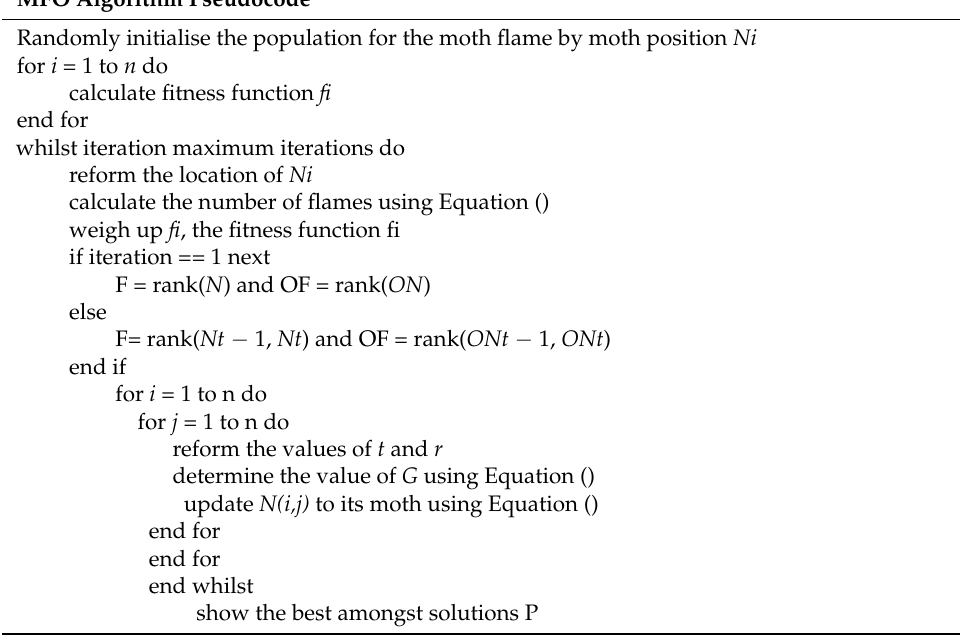
Table 2. Pseudocode of MFO. MFO Algorithm